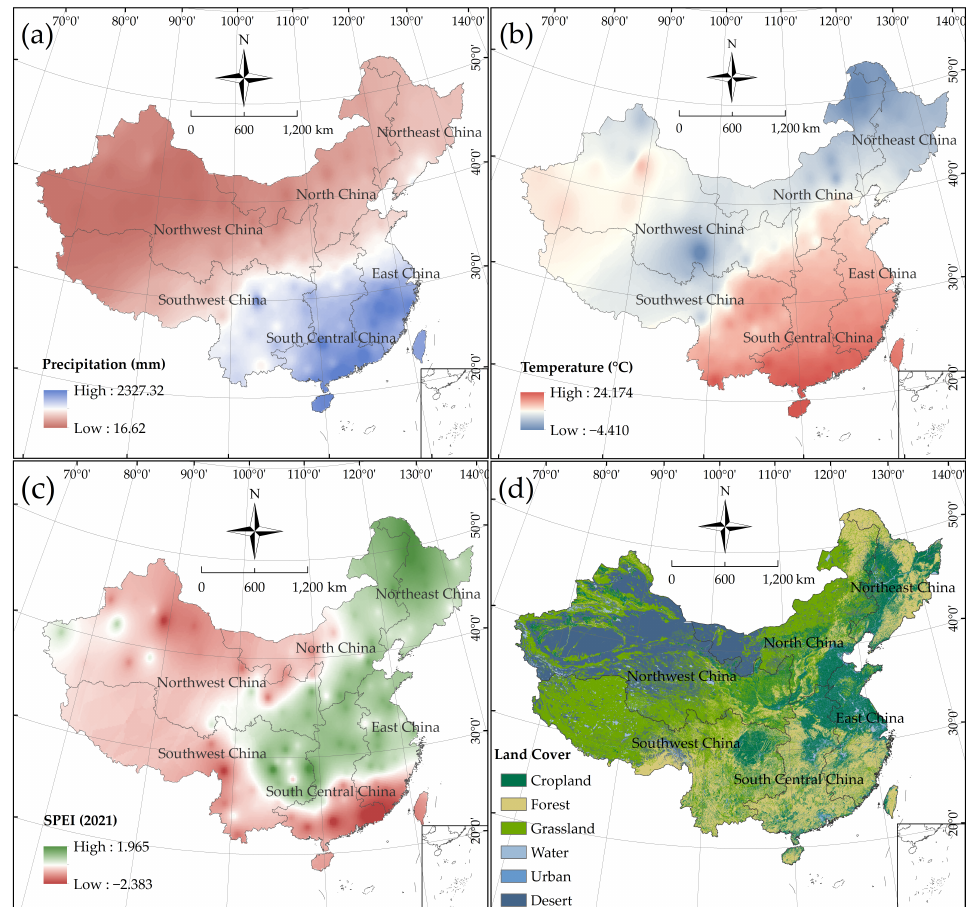
Figure 1. Main climatic and environmental characteristics in China: ( a ) mean annual precipitation, ( b ) mean annual air temperature from 1951–2021, ( c ) the SPEI at a 12-month timescale in 2021, and ( d ) land use/cover change